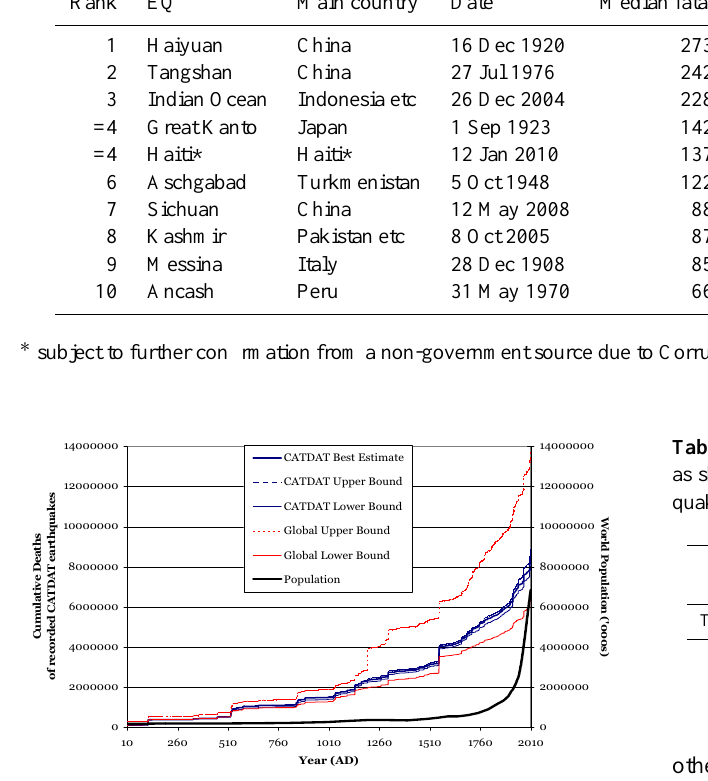
Fig. 6. The CATDAT estimates versus the smallest plausible and largest plausible fatalities from earthquakes from various literature sources. This is compared with the global population.